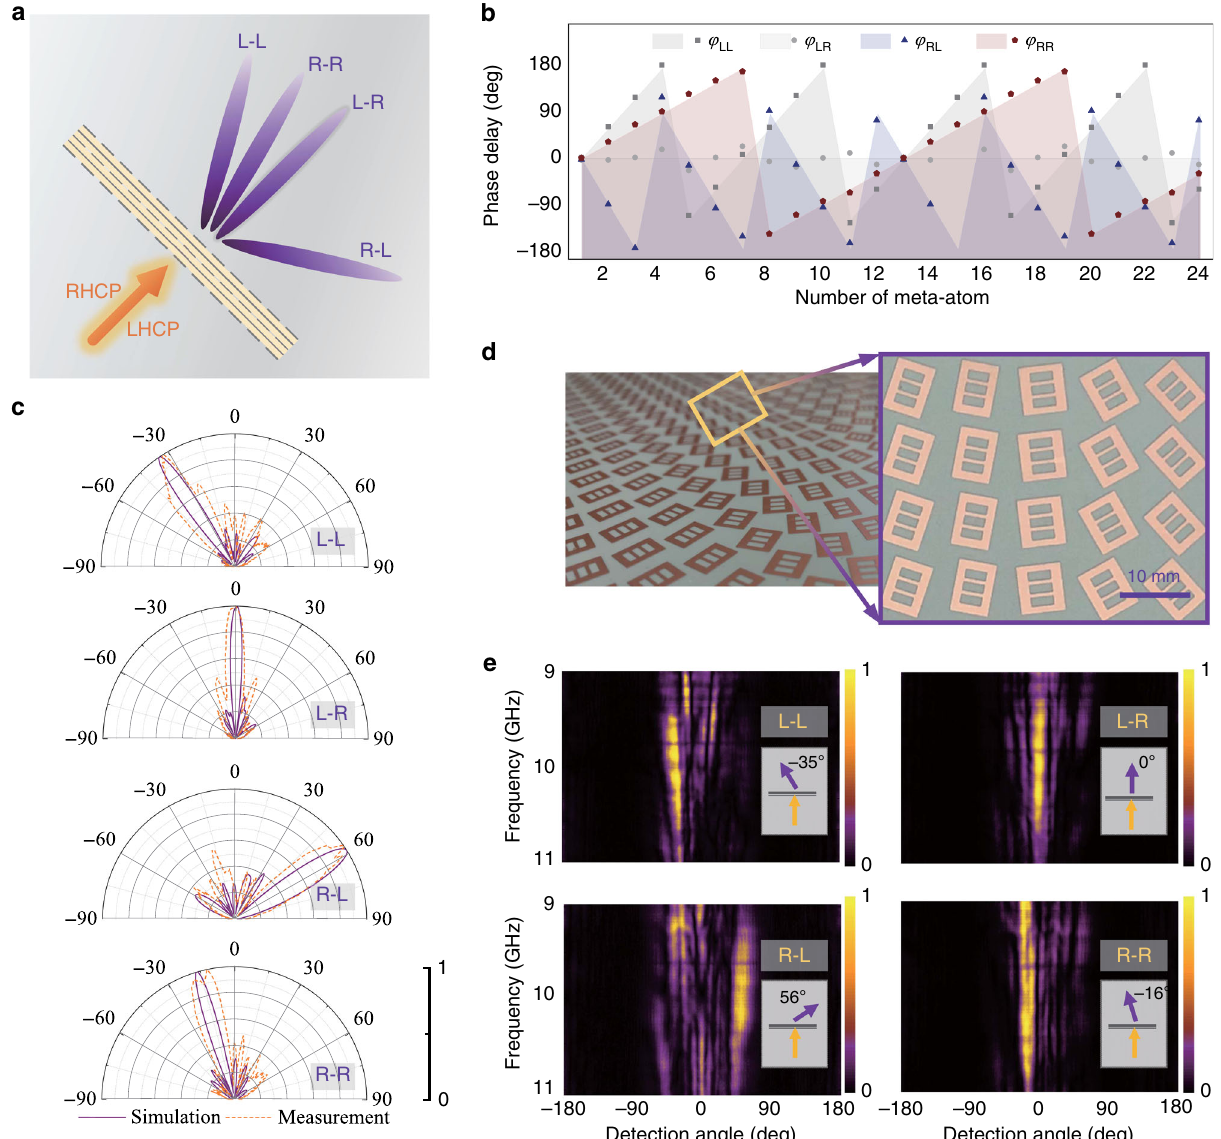
Fig. 3 Numerical and experimental results validating the performances of the meta-de fl ector. a Schematic of proposed meta-de fl ector. b Theoretical and simulated phase pro fi les of meta-atoms located along x -axis to provide required phase gradients in all four CP transmission channels. c Simulated and measured normalized far- fi eld patterns for channels L – L, L – R, R – L, and R – R at 10 GHz, respectively. d Photograph of fabricated sample of proposed meta- de fl ector. e Measured normalized far- fi eld intensities against frequency bandwidth (9 – 11 GHz) and detection angles for channels L – L, L – R, R – L, and R – R,